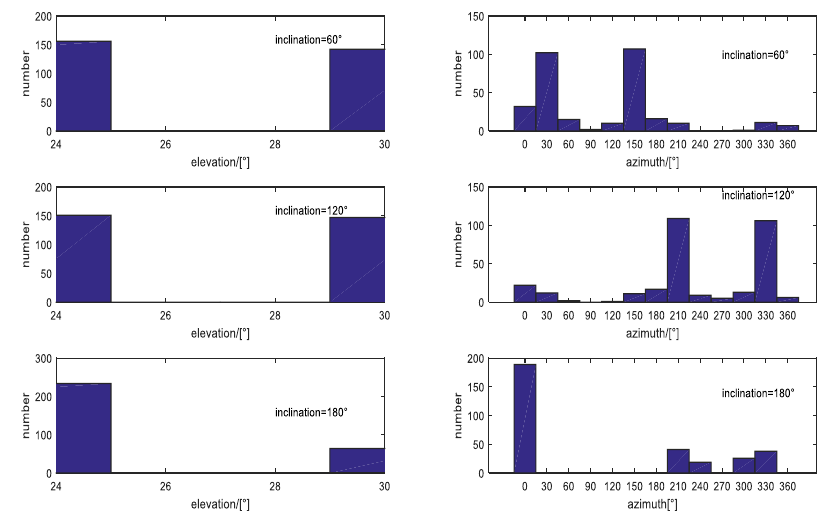
Figure 10. Variations in the elevation and azimuth with orbital altitude.